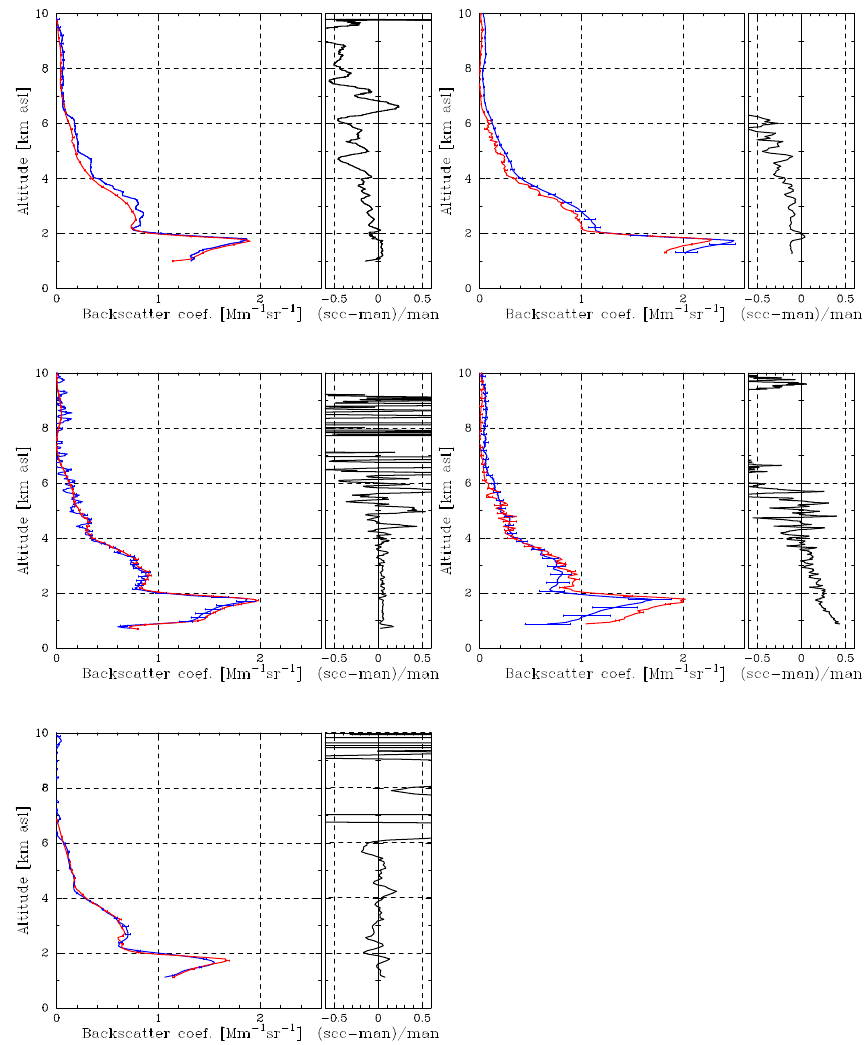
Figure 6. Comparison of backscatter coefficient profiles at 532nm derived with the Raman method for five lidar systems participating in the EARLI09 inter-comparison campaign. All profiles refer to the measurement session taken from 21:00 to 23:00UT on 25 May 2009, and they have been retrieved combining elastic-backscatter signals at 532nm and the corresponding N 2 Raman backscatter signals at 607nm. The profiles in blue are the analyses provided by the originator of the data using his/her own analysis software. The profiles in red are the ones retrieved by the SCC. From left to right, upper panel: RALI, MARTHA; middle panel: Polly XT , MSTL-2; bottom panel: MUSA.